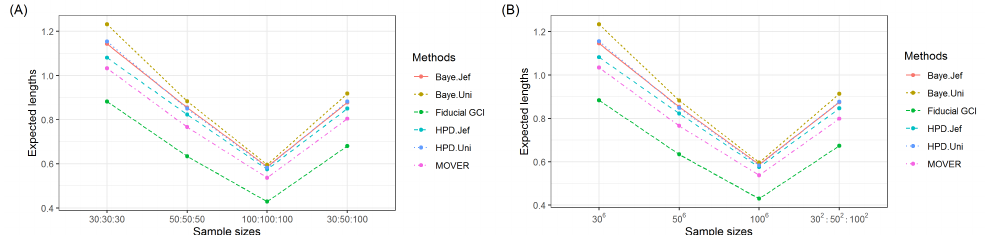
Figure 3. Expected lengths of the 95% simultaneous CIs with various sample sizes: ( A ) k = 3 and ( B ) k = 6.